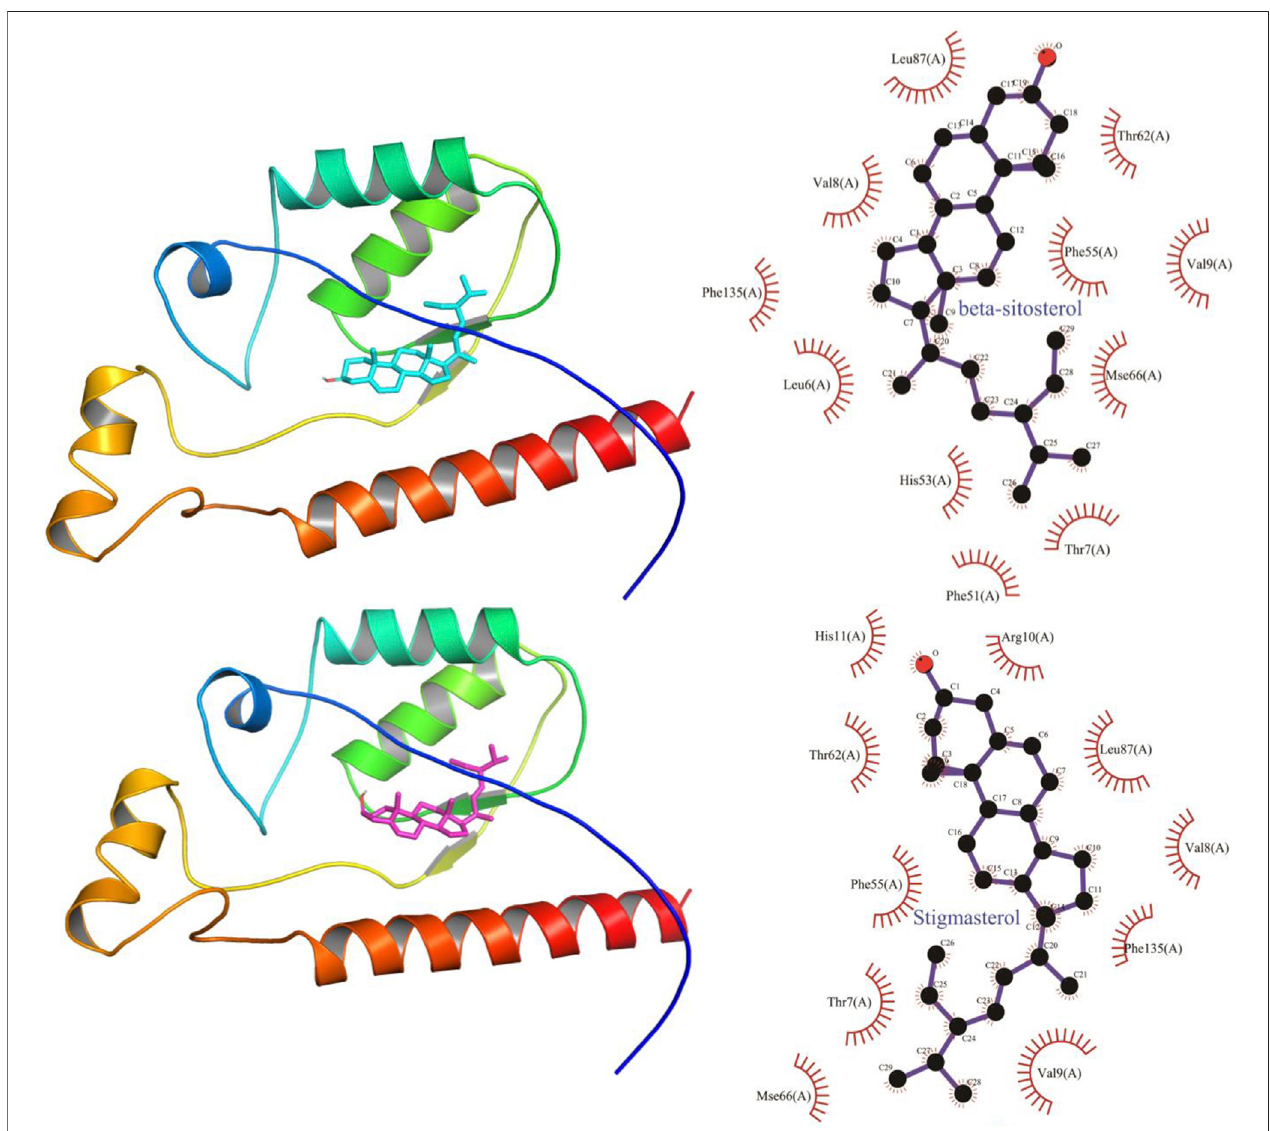
FIGURE 8 | Molecular docking diagram of TW core compounds and